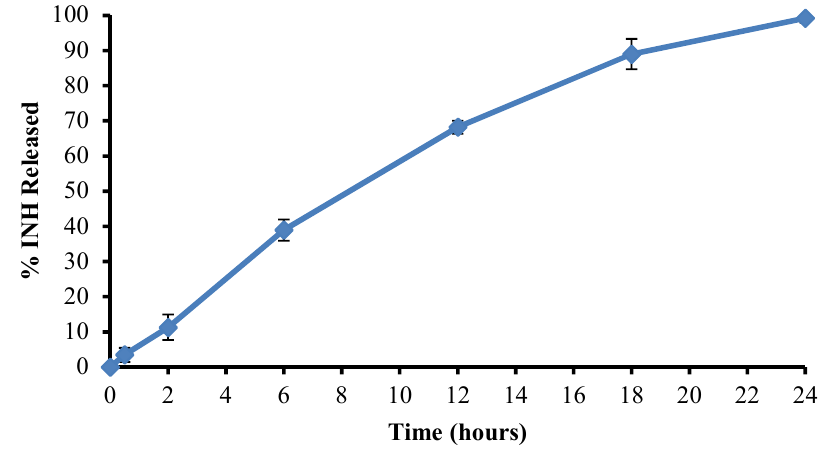
Figure 7. Mean dissolution profile (n = 6) of % INH released from the optimized formulation in pH 6.8 0.1 M phosphate buffer.